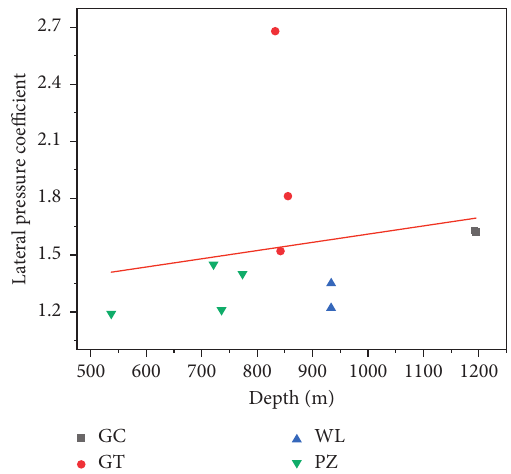
Figure 3: Variation of the pressure measuring coefficient with the depth.